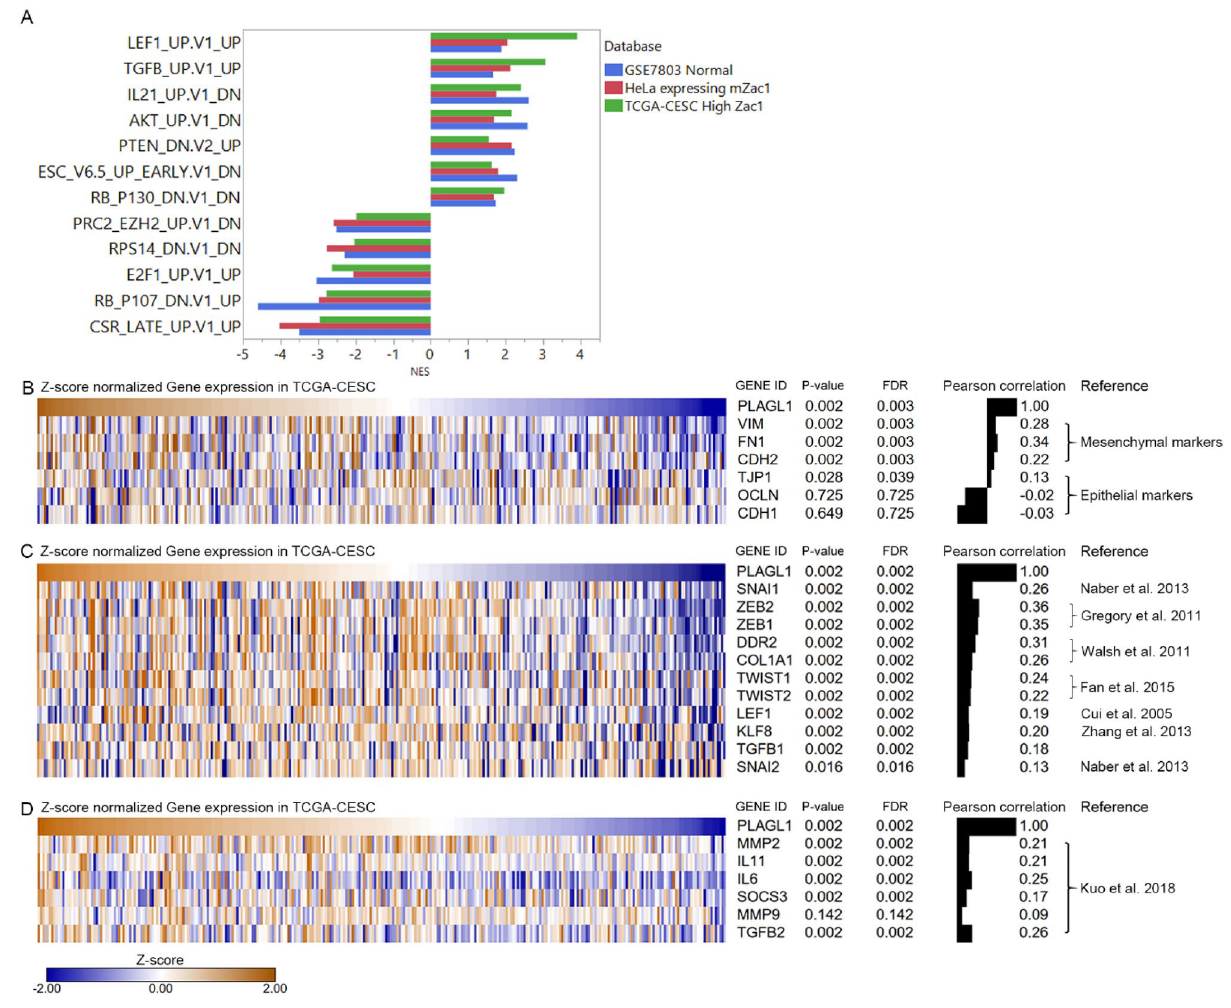
Figure 6. Identification the enriched oncogenic signature and related gene expression in TCGA-CESC. Normalized enrichment scores of oncogenic signatures produced by GSEA. (B–D) Correlations between gene expressions of Zac1/PLAGL1 and EMT biomarkers (B) , TGFβ related EMT genes (C) and reported Zac1 target genes (D) 26 . P -value and FDR (False Discovery Rate) by Pearson correlation